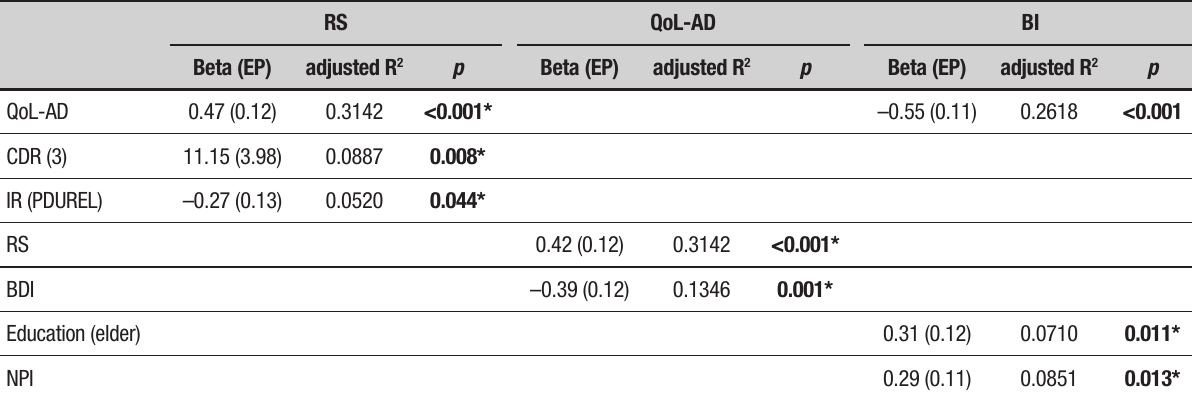
Table 4. Multivariate linear regression analysis of higher resilience, better perceived quality of life and burden of the family